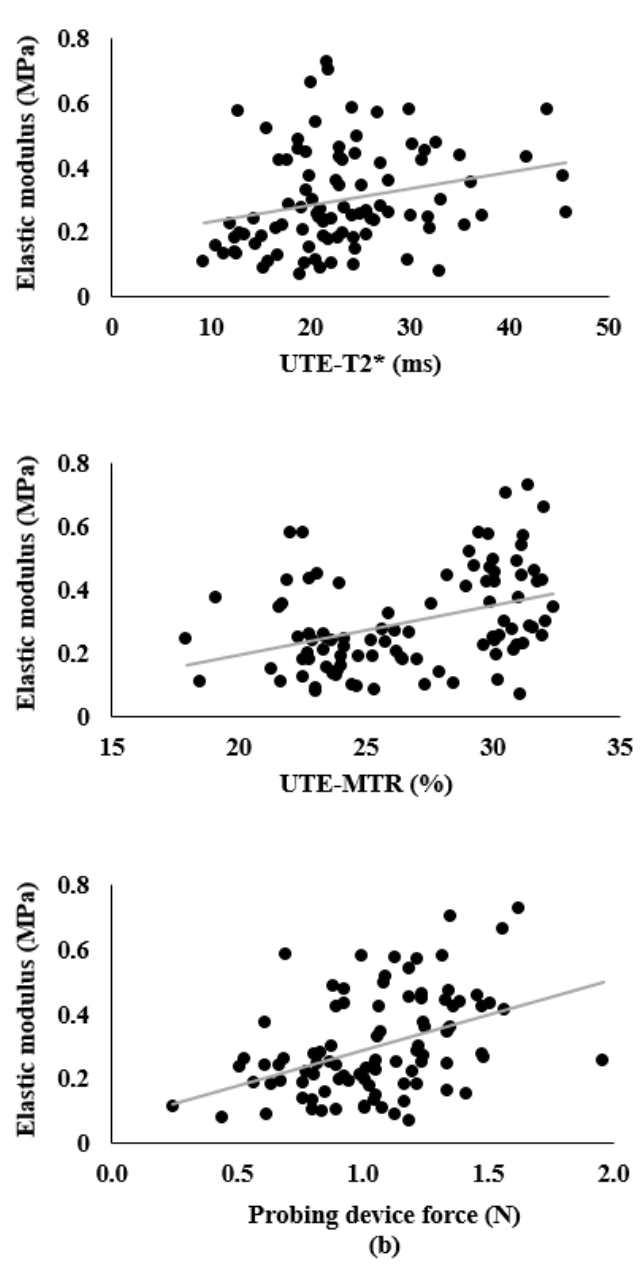
Figure 6. Scatterplots of: ( a ) stiffness by ultrashort echo time transverse relaxation time (UTE-T2*), ultrashort echo time magnetization transfer ratio (UTE-MTR), and probing device force, and ( b ) elastic modulus by UTE-T2* UTE-MTR, and probing device force. Table 2. Pearson correlation coefficients among variables.